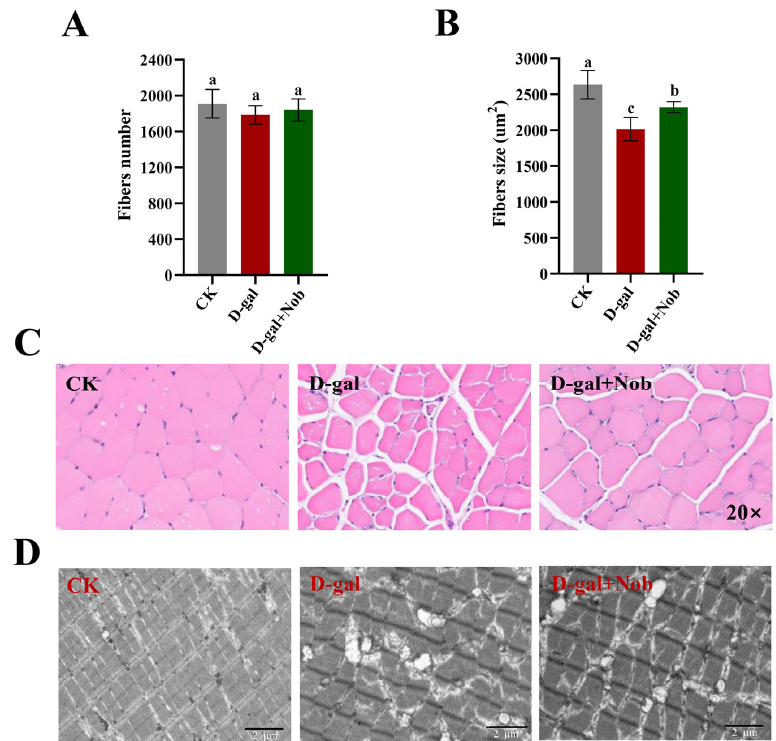
Figure 2. Nob improved skeletal muscle atrophy in D-gal-induced aging mice. ( A ) The number of myofibers in the CK, D-gal, and D-gal + Nob groups, n = 5. ( B )The myofiber size (mean cross-section area) in the CK, D-gal, and D-gal + Nob groups, n = 5. ( C ) Representative images of hematoxylin and eosin (HE) staining of myofiber in the CK, D-gal, and D-gal + Nob groups (Magnification × 20), n = 5. ( D ) Representative images of myofiber ultrastructure in the CK, D-gal, and D-gal + Nob groups. Scale bar, 2 µm, n = 3. Significant differences between treatment groups are represented by the lowercase letters a, b, and c ( p < 0.05).